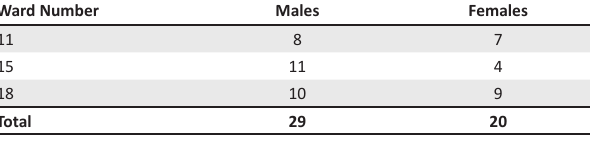
TABLE 1: Demographic characteristics of observers.